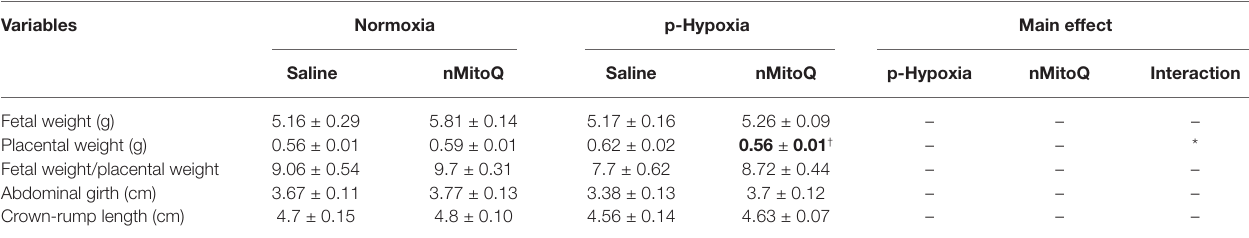
TABLE 3 | Fetal and placental characteristics of female